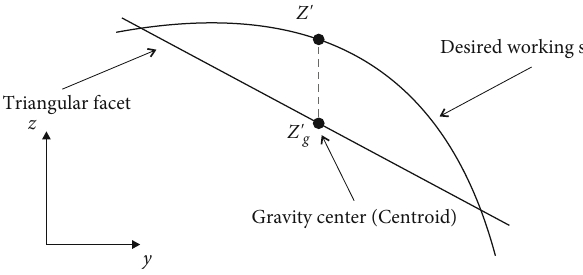
Figure 5: Geometric illustration of facet gravity center deviation RMS